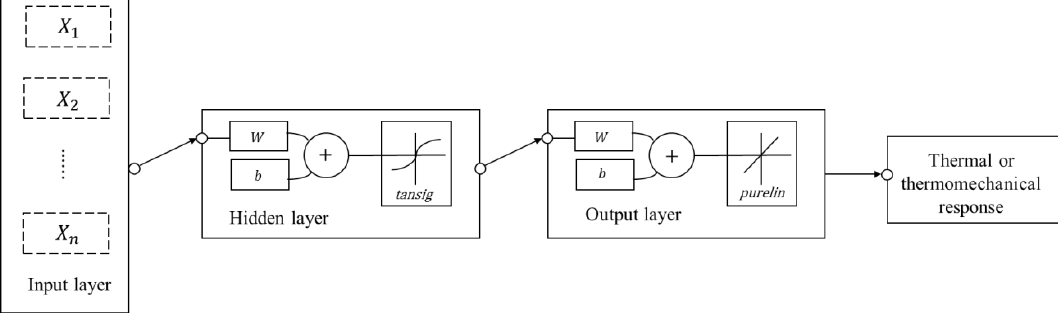
Figure 2. A schematic of a three-layer artificial neural network (ANN) model.